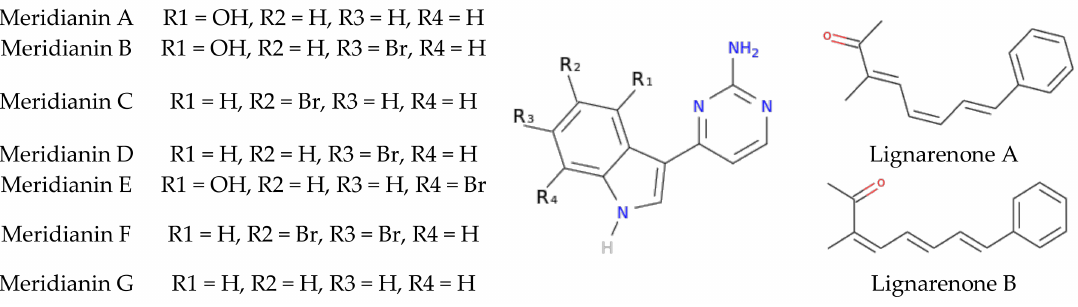
Figure 2. Structure of meridianins A-G and lignarenones A-B. Natural compounds isolated from marine